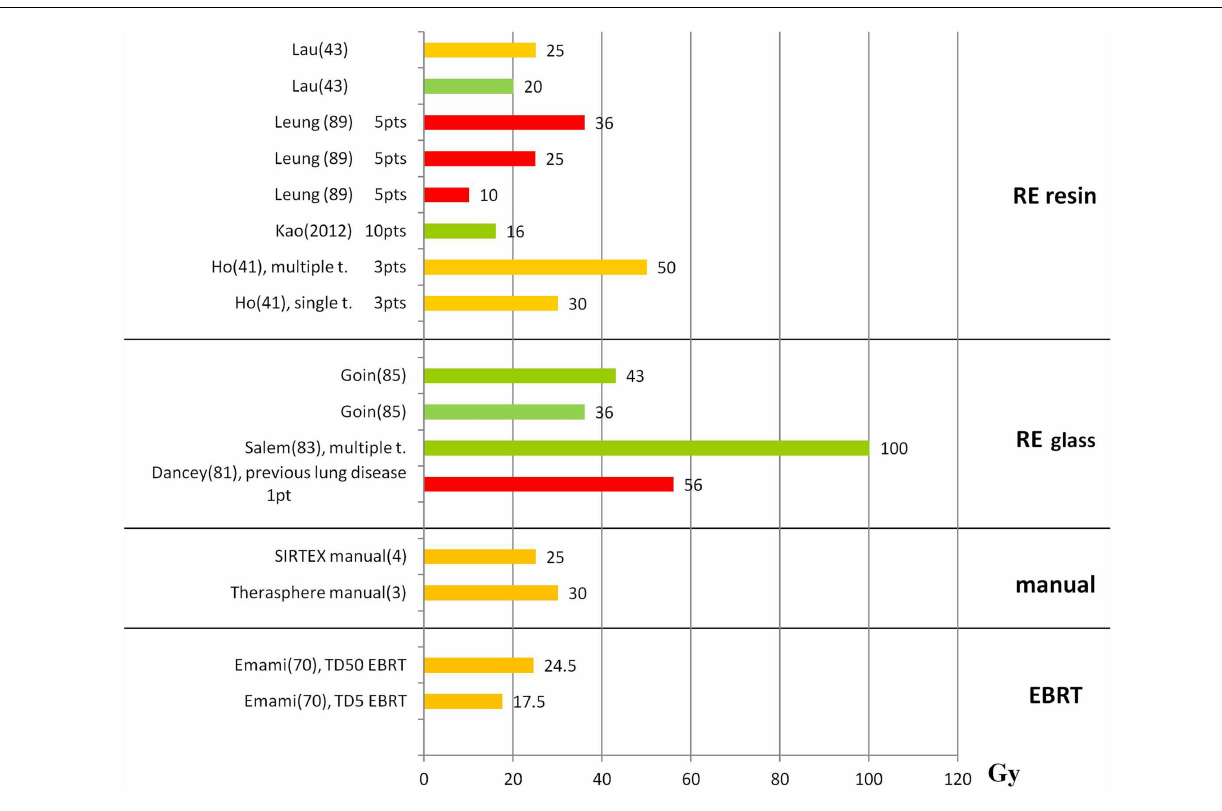
FIGURE 2 | Lung absorbed doses (Gy) and tolerability .The graph shows the lung absorbed doses (Gy) reported in the literature, with information about the associated lung tolerability.The absorbed doses taken from the literature are reported although these are derived without including the attenuation correction. Absorbed dose values should be rescaled by an